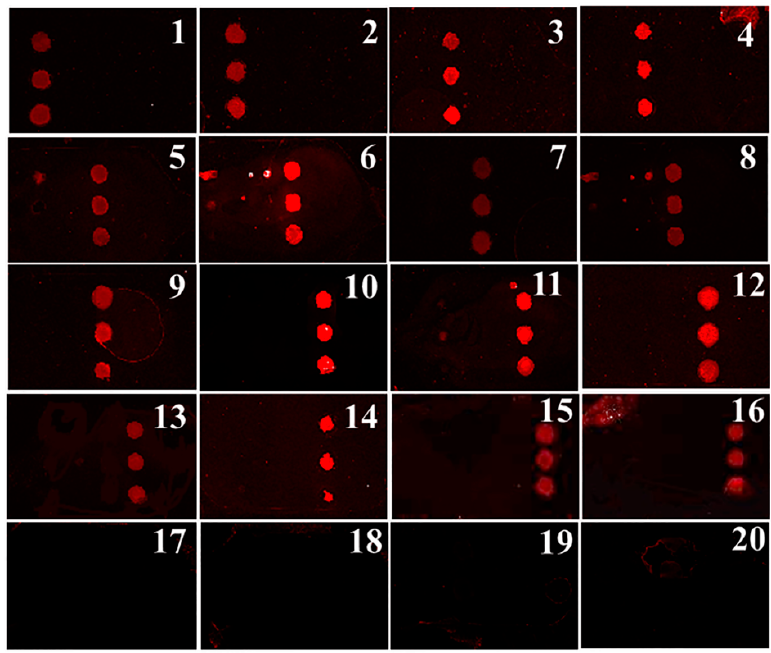
Figure 6. Multiplex detection of HPV genotypes from twenty clinical cervical swabs by the integrated array chip. Table 1. The HPV genotypes of twenty clinical samples detected by the chip and by real-time PCR. Sample ID